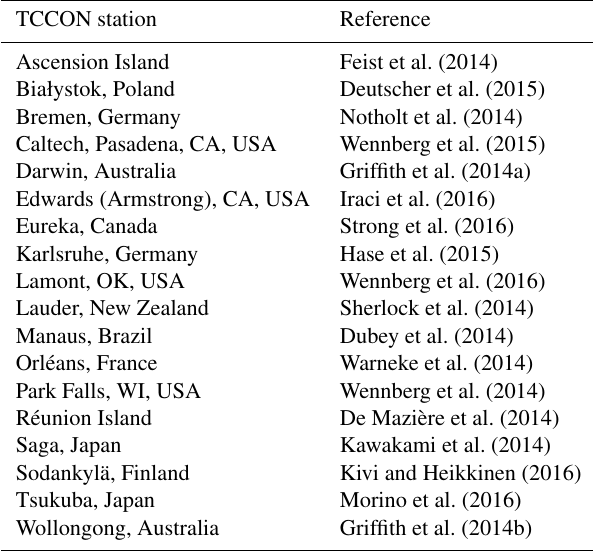
Table 1. TCCON stations used in this work for evaluation of inverse